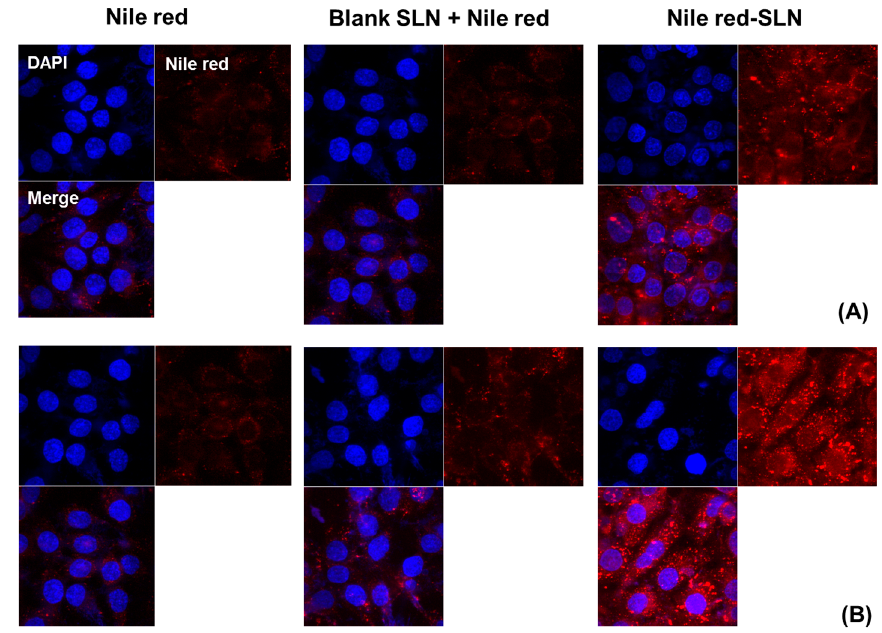
Figure 7. Cellular uptake of Nile red solution, Nile red with blank SLN and Nile red-loaded SLN for ( A ) 4 and ( B ) 8 h of incubation in MCF-7 cells ( n = 3, mean ± SD). DAPI (4 ′ ,6-diamidino-2-phenylindole), Nile red, and Merge represent the nuclear staining (blue), the distribution of Nile red (red), and the merged image,